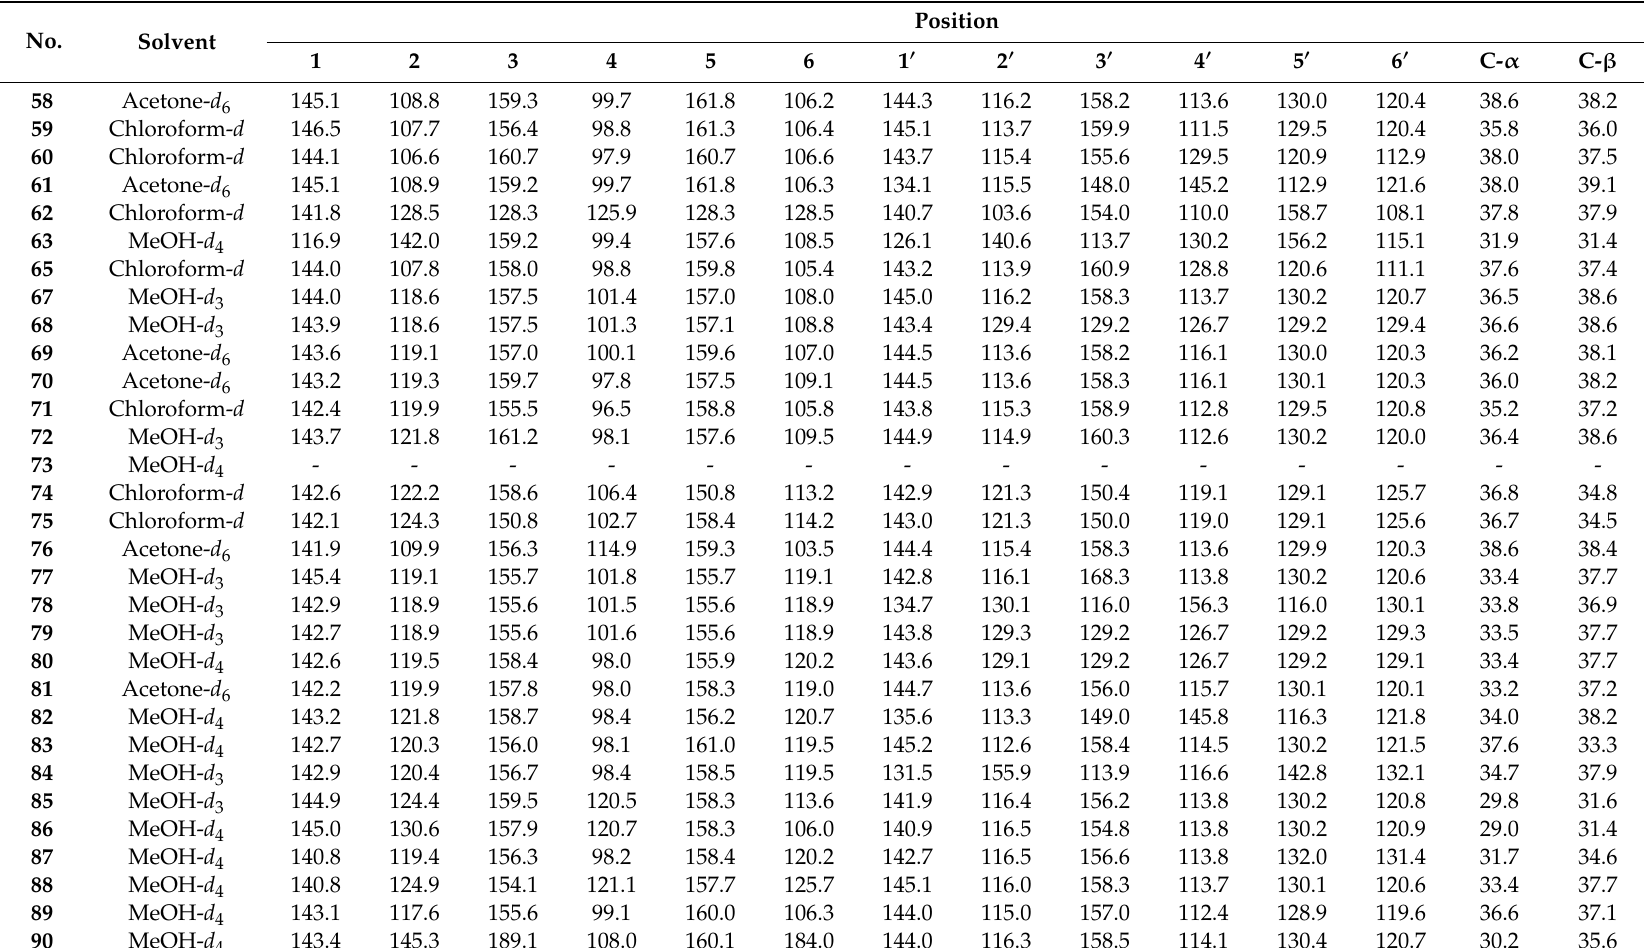
Table 5. 13 C NMR data of compounds 58 – 101